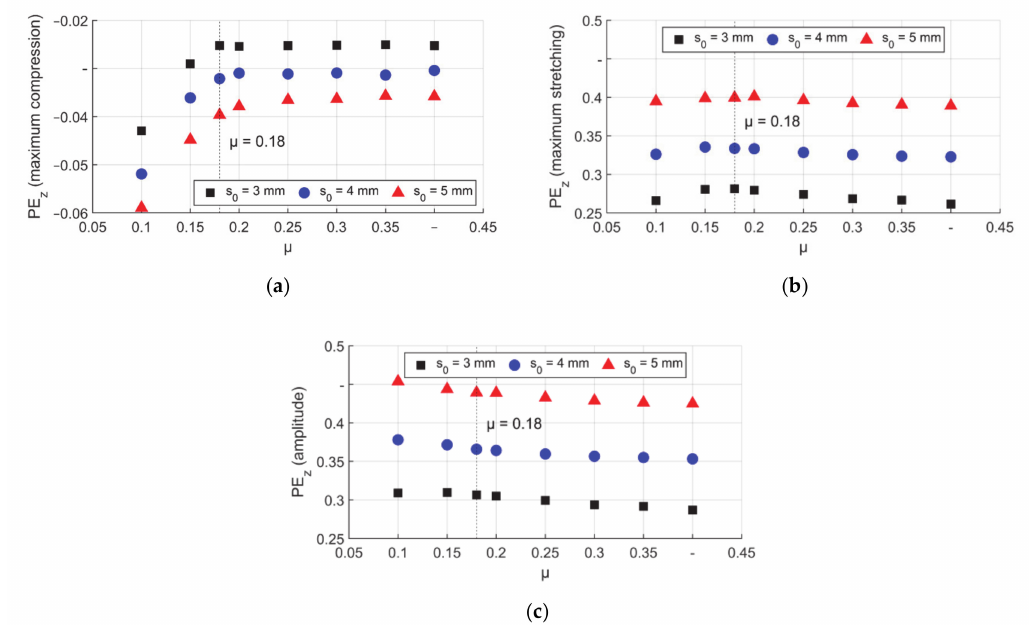
Figure 21. Peak values of axial PE z on the inner surface, ( a ) maximum compression, ( b ) maximum stretching, and ( c ) amplitude.